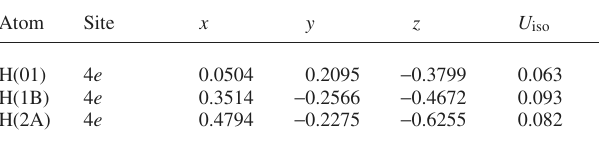
Table 2. Atomic coordinates and displacement parameters (in Å 2 )